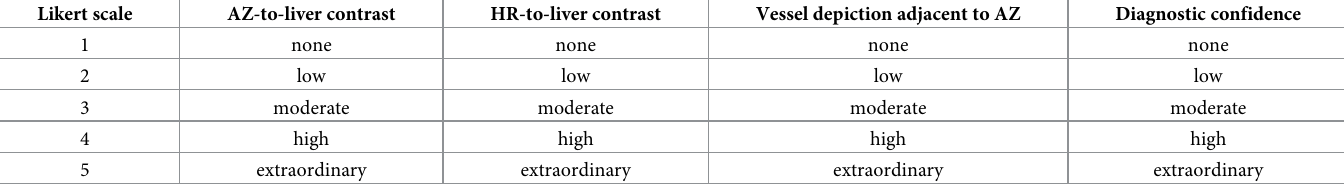
Table 2. Likert scales of qualitative